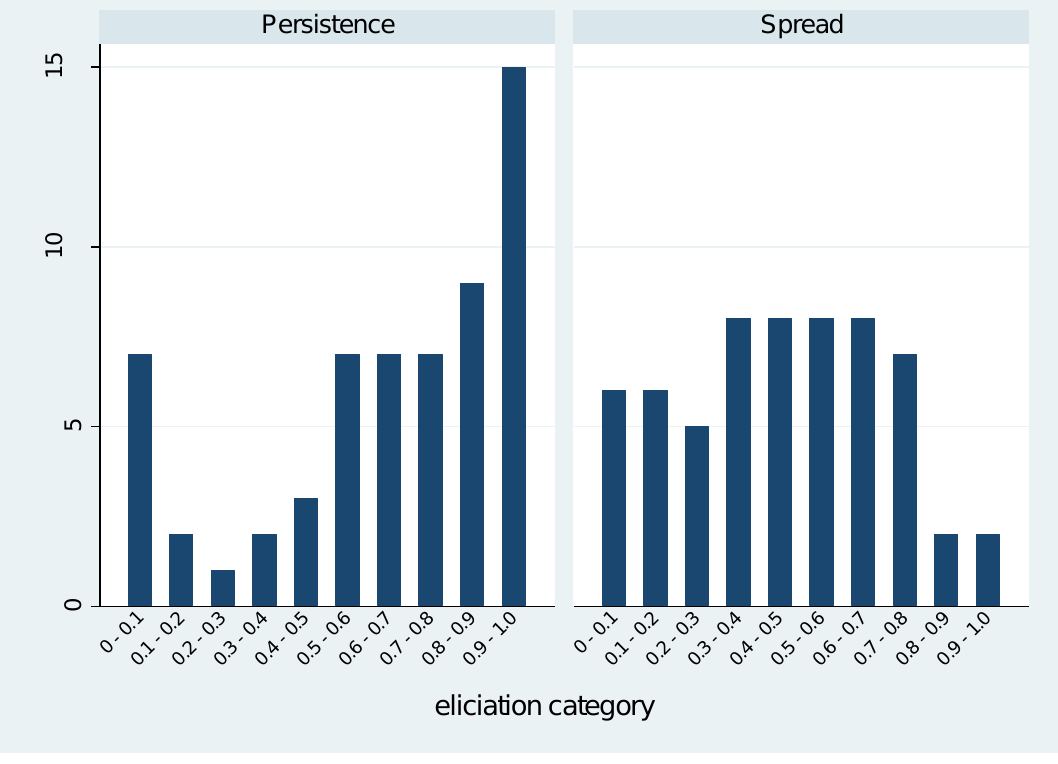
Figure 1. Prior distributions of the expert panel elicitation.